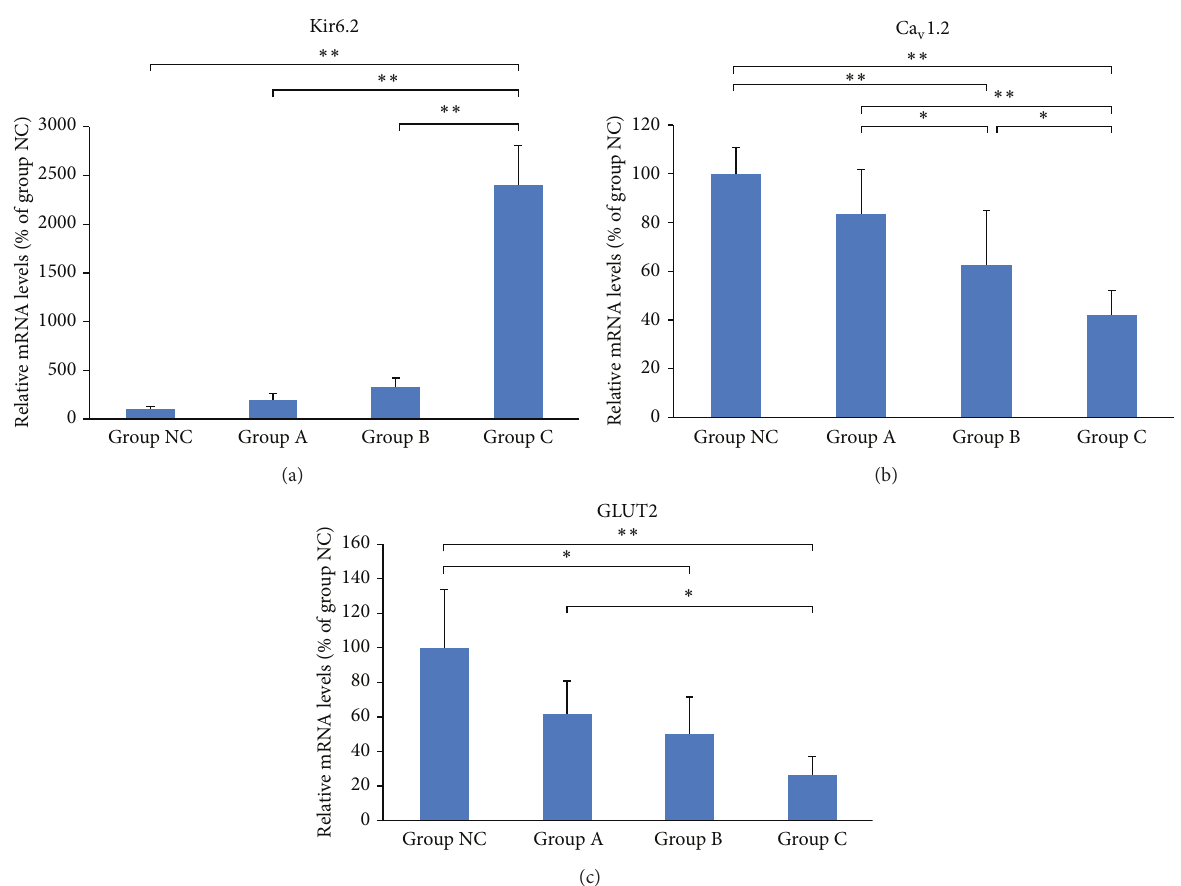
Figure 4: Effects of simvastatin on mRNA levels of Kir6.2 (a), Ca v 1.2 (b), and GLUT2 (c) in MIN6 cells. ∗ 𝑃 < 0.05 and ∗∗ 𝑃 < 0.01 .